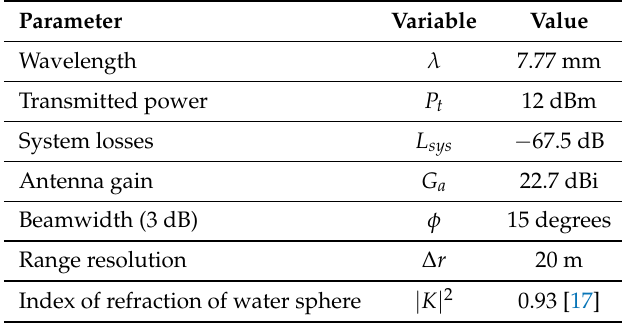
Table 2. Radar parameters for internal calibration. The system losses are negative because they include the receiver